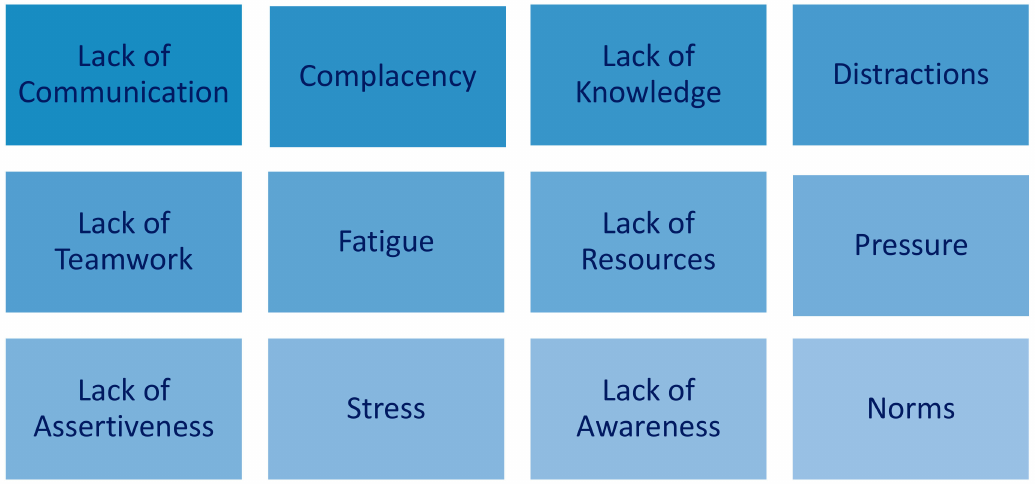
Figure 1. The Dirty Dozen